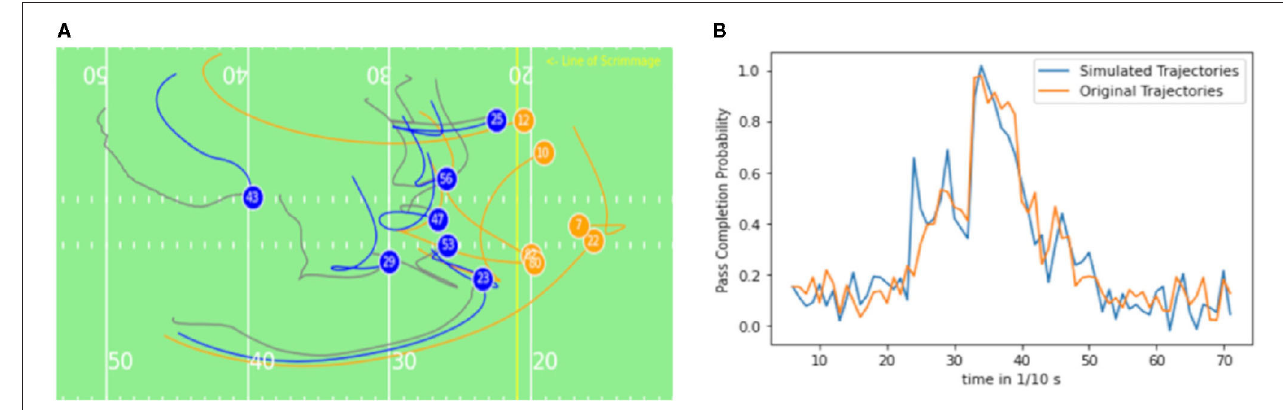
FIGURE 9 | (A) Exemplary long play ( ≈ 7.2 s): The Quarterback (7) throws a pass to a receiver (12) on the right side of the field. Offensive players are illustrated in blue, defenders orange and ghosted trajectories in gray color. (B) Pass completion probability over the course of the play for the ghost/simulated trajectories and true/original